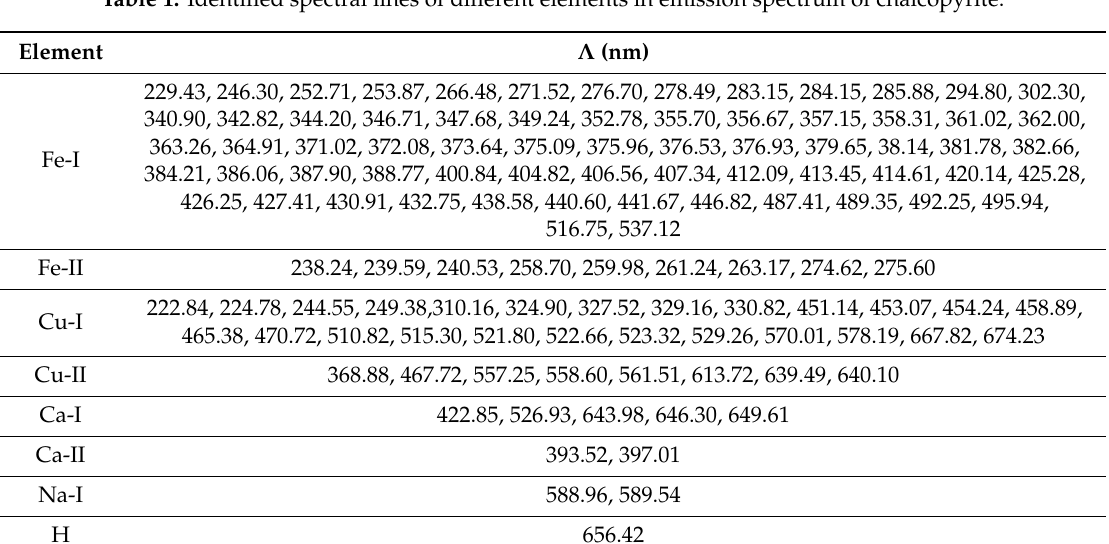
Figure2. Opticalemissionspectrumofchalcopyriteplasmarecordedinthespectralrangeof200–720nm. Figure 2. Optical emission spectrum of chalcopyrite plasma recorded in the spectral range of 200–720 nm. Table 1. Identified spectral lines of di ff erent elements in emission spectrum of